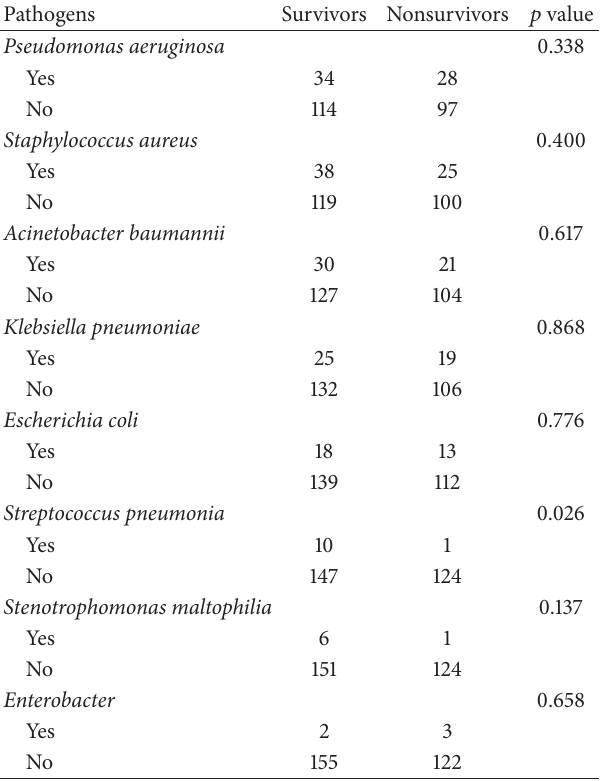
Table 3: Difference in mortality among pathogens in severe pneu-